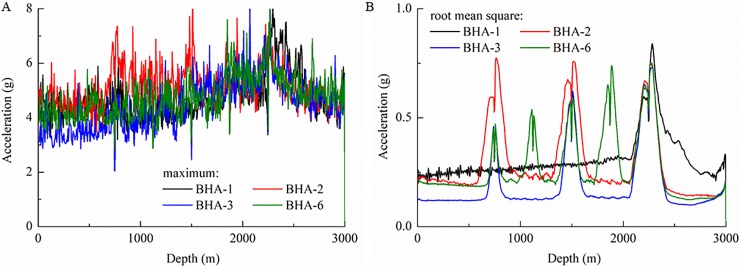
Acceleration along the drill-string.(A) Maximum acceleration. (B) Root mean square acceleration. https://dx.doi.org/10.17504/protocols.io.ke7cthn.